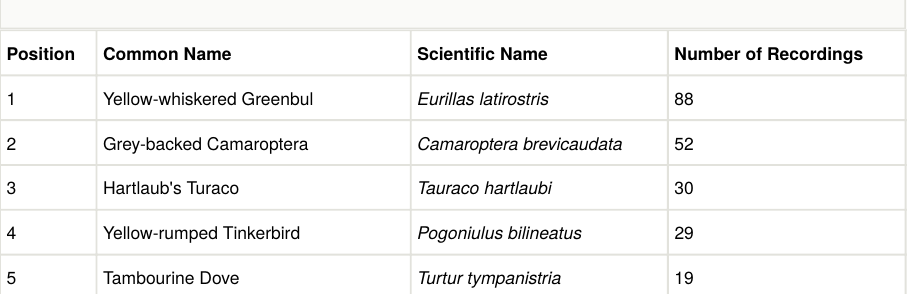
Number of foreground recordings per